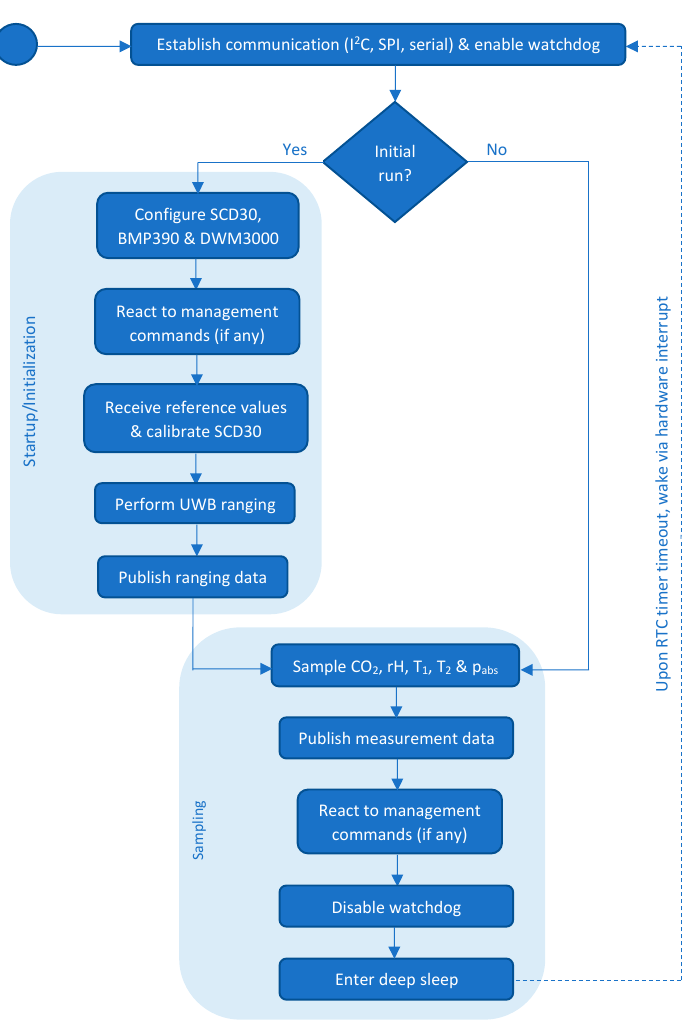
Figure 3. Program sequence of the measurement node software.